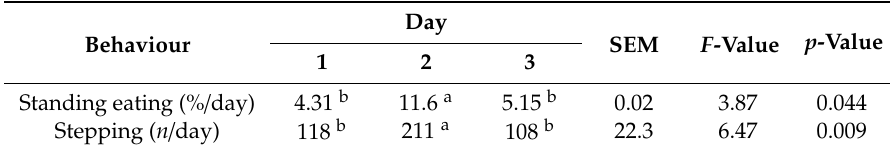
Table 6. E ff ects of the day of the journey in behavioural responses of cattle subjected to long distance transport by